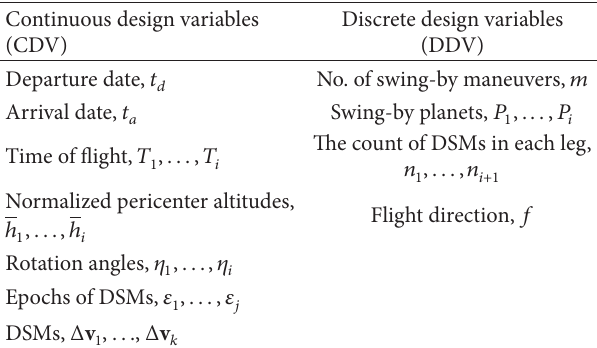
Table 1: The discrete and continuous independent design variables of the MGADSM